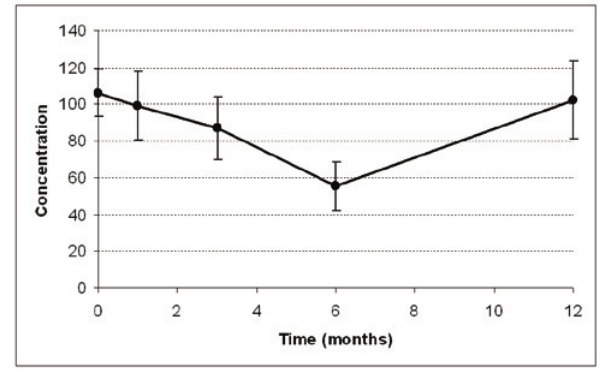
Figure 1 - Variation of sperm Concentration per mL over time.